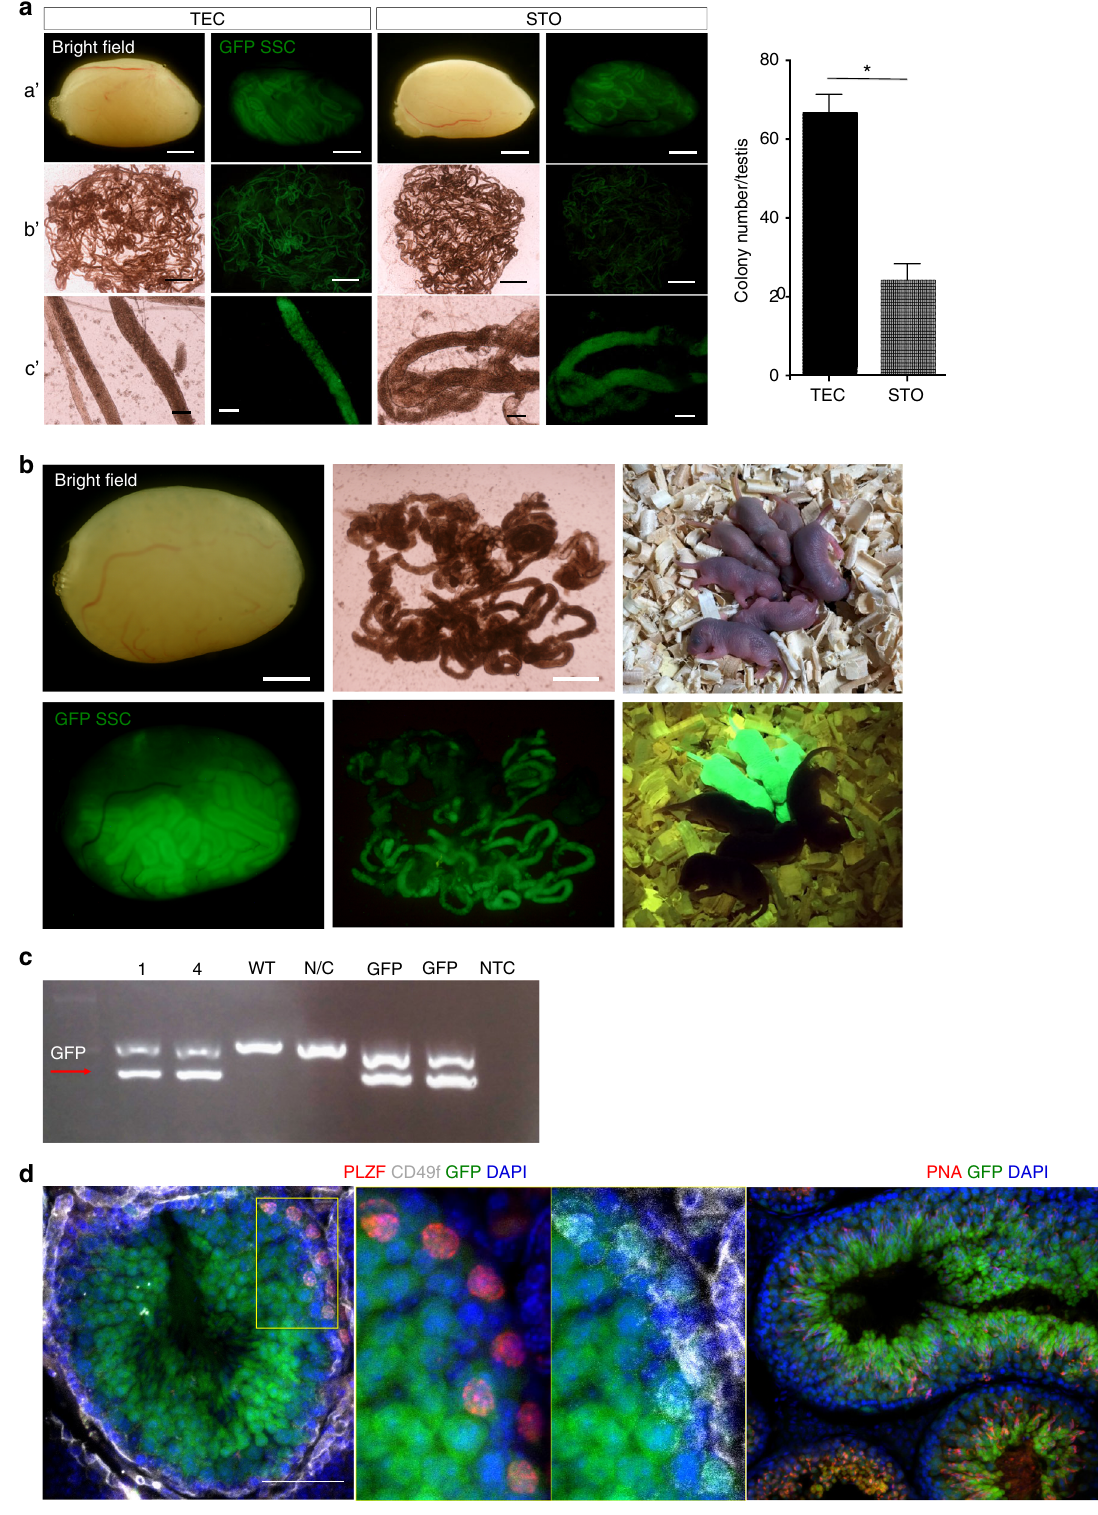
Fig. 3 SSCs cultured long term with TECs restore spermatogenesis and fertility in mice. a Images of testes from busulfan-treated mice 12 weeks after transplantation with GFP + SSCs co-cultured long term with either TECs or STO feeder cells. Quanti fi cation of GFP + SSC colonies is shown on right. Data shown are out of three independent experiments. a ’ : Bar = 2 mm, b ’ : bar = 4 mm, c ’ : bar = 200 μ m. * P < 0.05. b Images of testes and GFP + pups 16 weeks after transplantation of GFP + SSCs co-cultured long term with TECs into infertile W/W v mice. Bar = 2 mm. c PCR of gfp expression in GFP + pups (1, 4) non-GFP + pups (WT), negative control (N/C), positive controls (GFP, GFP) and a no DNA template control (NTC). d Images of testis sections immunostained with the undifferentiated spermatogonia markers PLZF and Cd49f as well as the spermatid marker PNA. Testes were from mice transplanted with GFP + SSCs after long-term co-culture with TECs. Data shown are out of six independent experiments. Two-tailed unpaired T